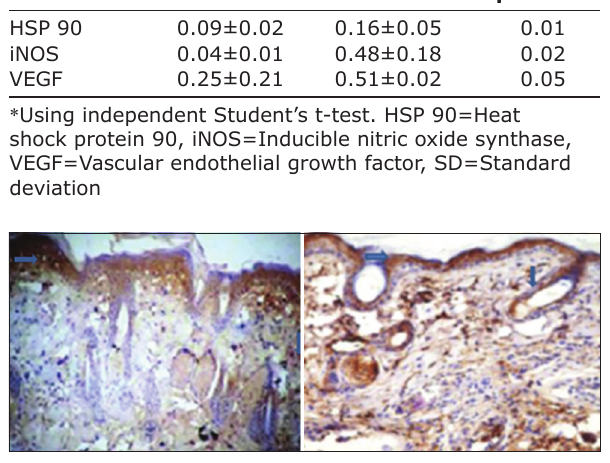
Figure-1: Immunohistochemistry image showing the extent HSP 90 expression in skin of diabetic rats (left) and control rats (right). Arrows point at brown color indicating HSP 90 (40×). There was a significant difference in the expression of HSP 90 in the skin of control rats when compared to that in alloxan-induced diabetic rats. HSP 90=Heat shock protein 90.